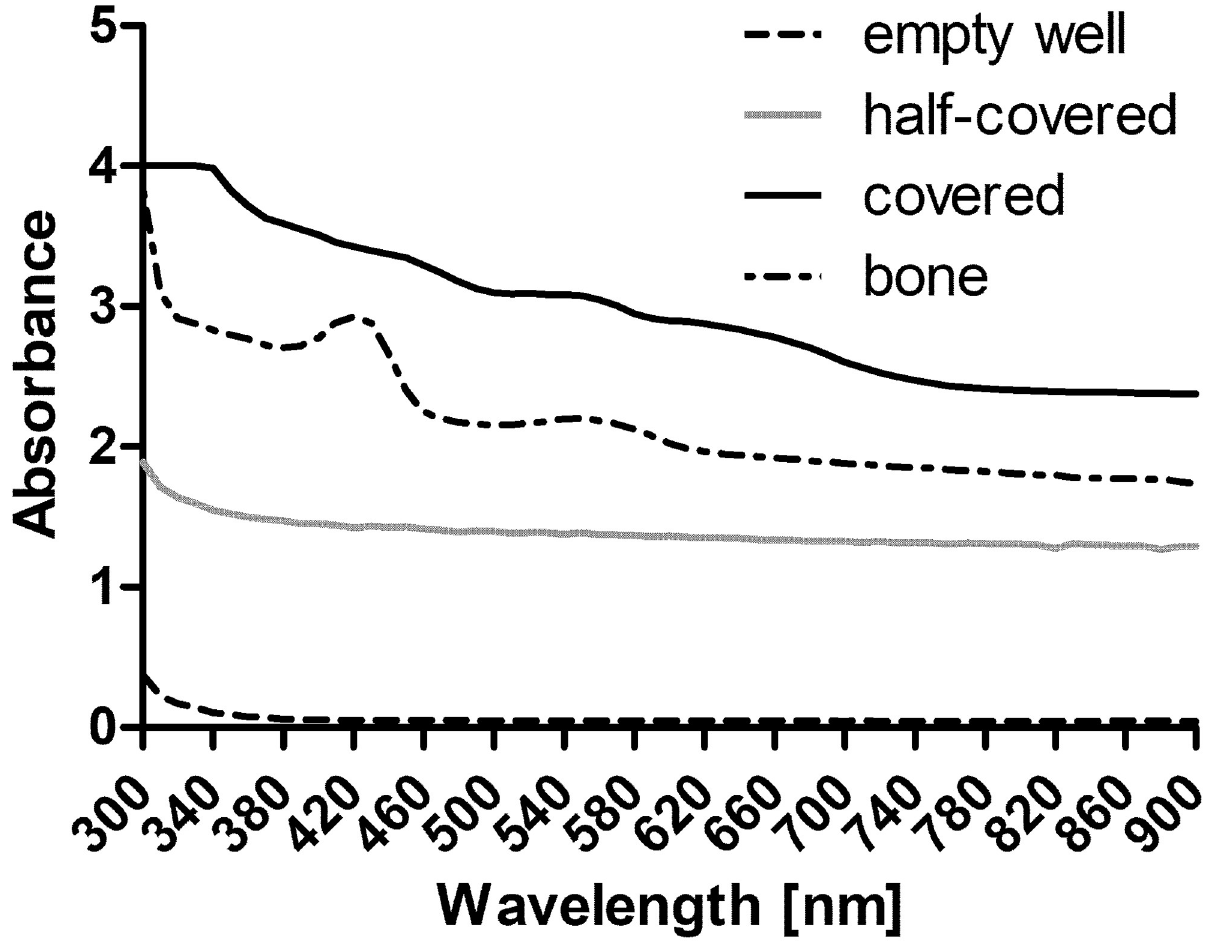
Fig 4. Spectral scan of control wells from 300 nm to 900 nm. To determine the upper and lower limits, wells were covered (black line) or partly covered (grey line) with paper or the bottom of the well was covered with bone (dotted line). For comparison a spectrum of an empty well (dashed line) is